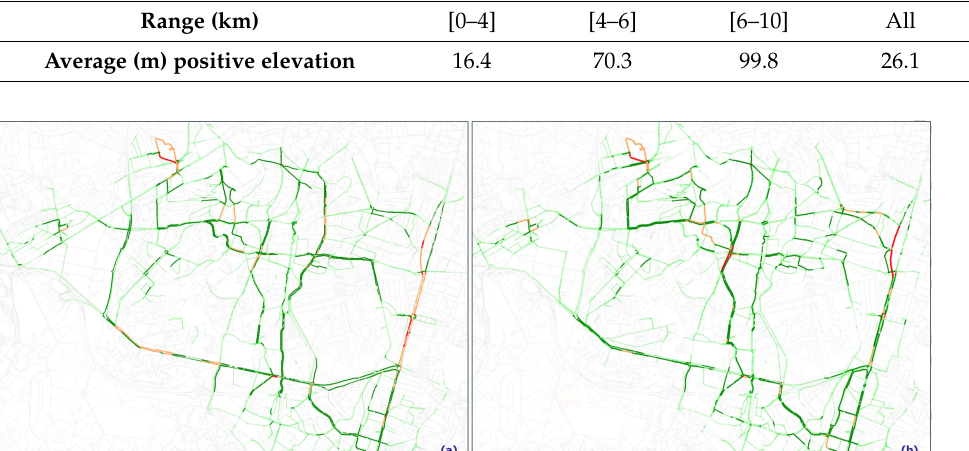
Table 4. Bicycle trips: positive elevation for short, intermediate and long trips.